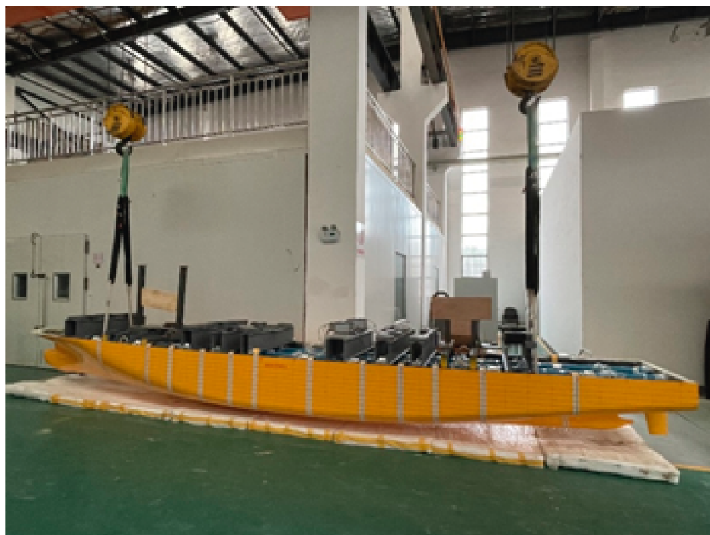
Figure 8: Different suspending patterns in the measurement of the modal